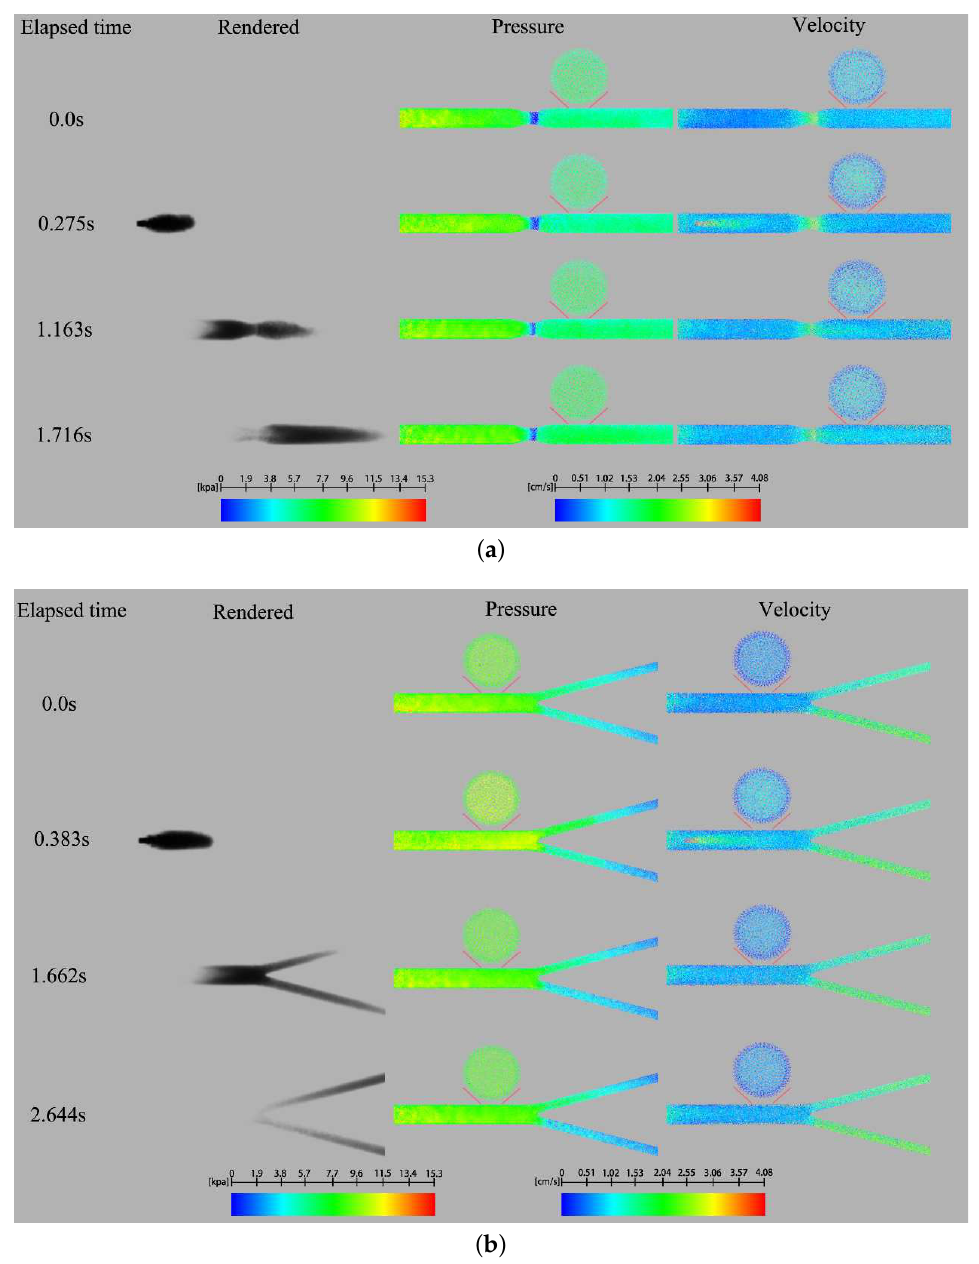
Figure 6. Contrast media diffusion simulation in two typical vessels. ( a ) Stenosis vessels; ( b ) Y-type